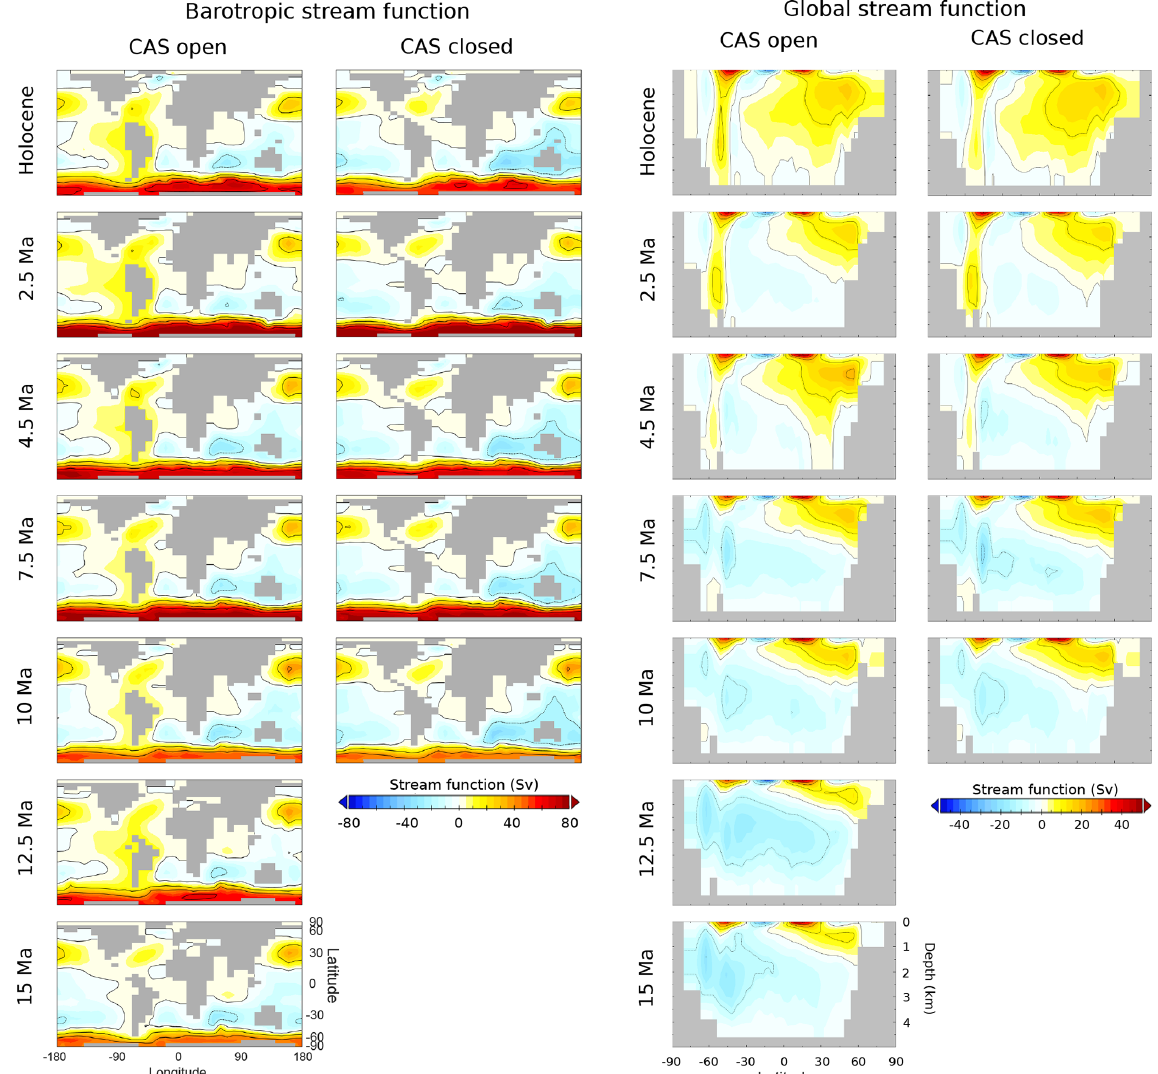
Figure 13. Modelled barotropic stream function (left) and global stream function (right) for each time slice for the best fit model settings. Contours for the barotropic stream function are at 20Sv intervals, and contours for the global stream function are at 10Sv intervals. Note the difference in colour scale between the barotropic and global stream